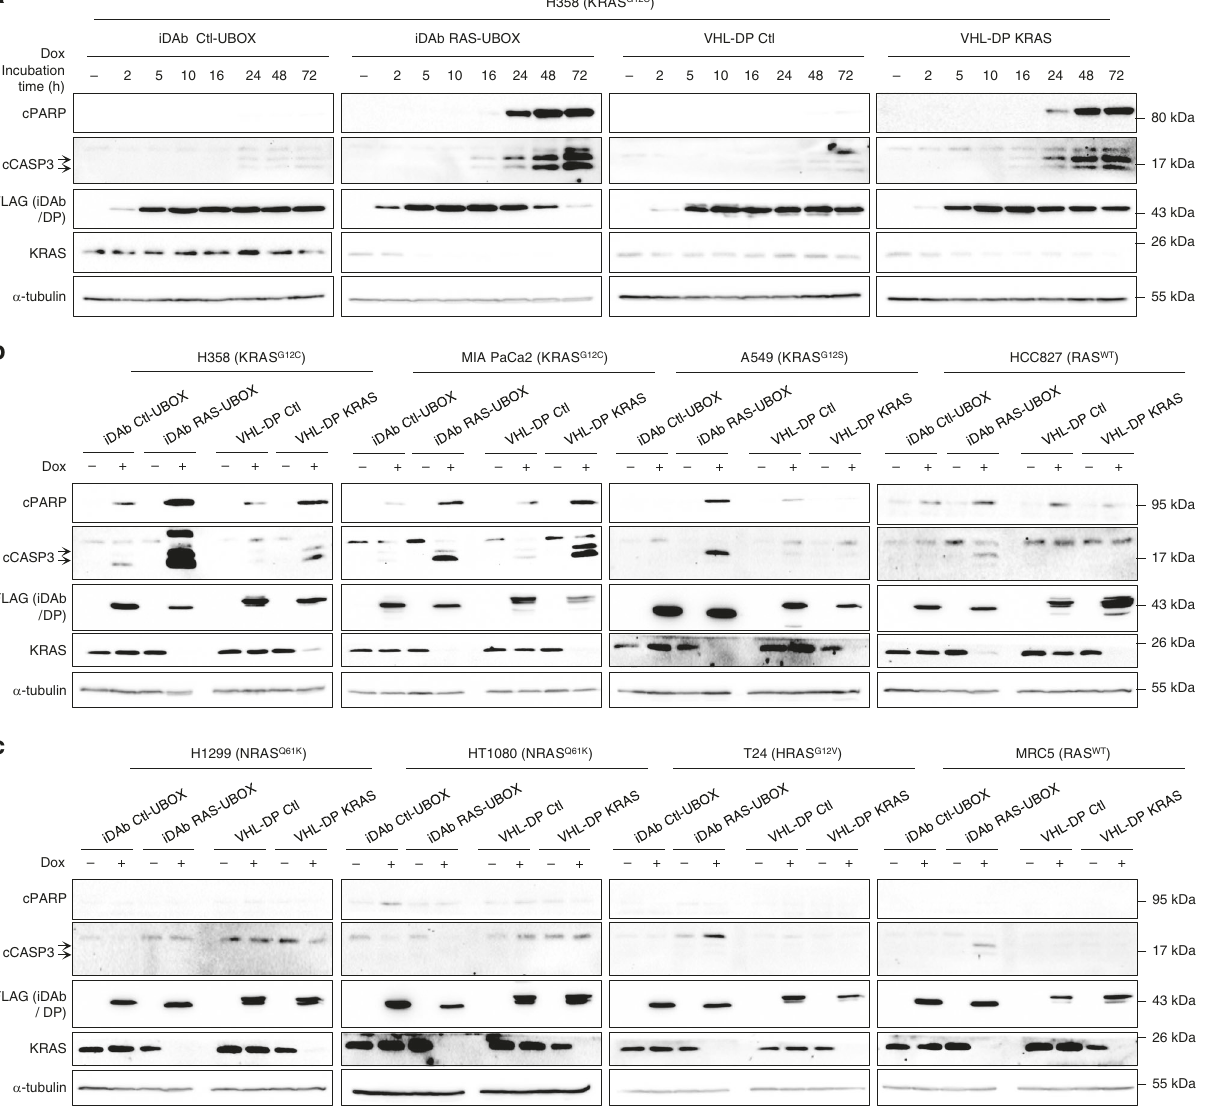
Fig. 7 KRAS protein depletion by the KRAS degrader leads to apoptosis of mutant KRAS dependent cells. a Western blot analysis of the apoptosis indicators, viz. cleaved PARP (cPARP) and cleaved caspase 3 (cCASP3) induced after expression of the degraders in H358 cells in a time response experiment. b , c Western blot analysis of the two apoptosis markers after expression of the degraders in 2D-adherent cultures of all 8 cell lines tested in this study after 72 h of doxycycline treatment at 0.2 μ g.mL − 1 ( + ) or not induced ( − ). α -tubulin is the loading control. The two arrows indicate the